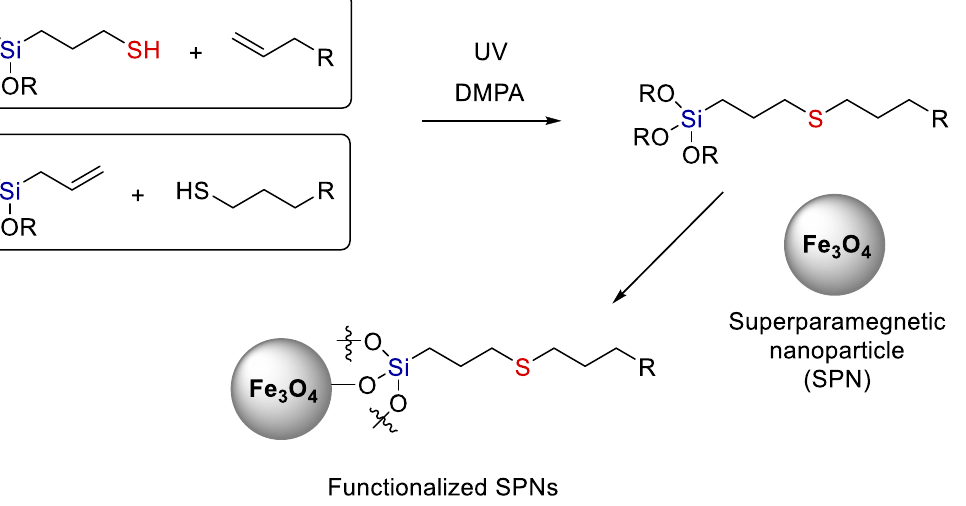
Figure 7. A scheme of modifying trialkoxysilanes by the thiol-ene reaction. Adopted from Ref. [28].